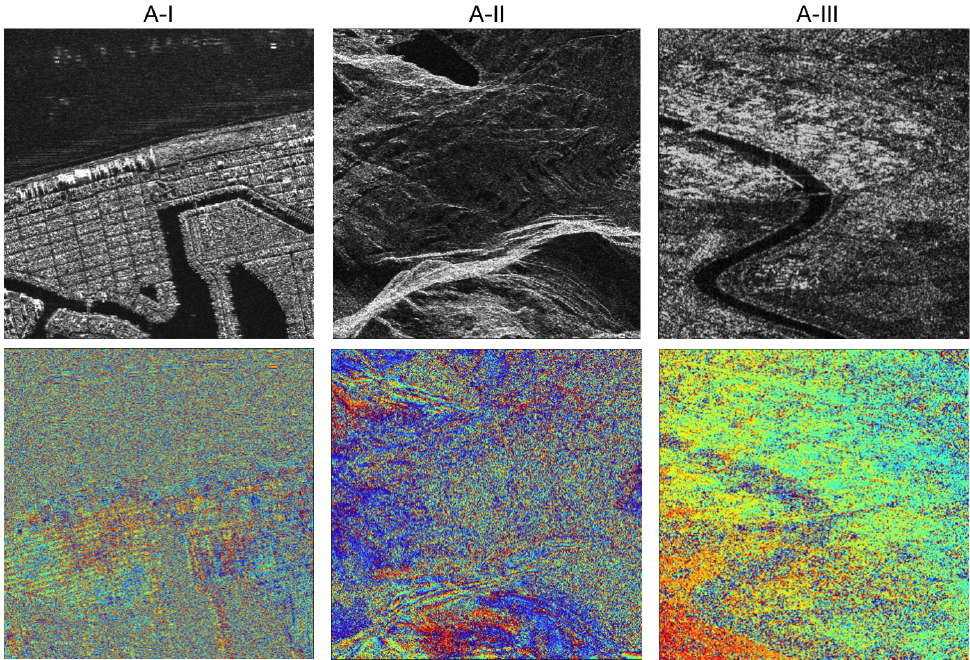
Figure 17. Amplitude ( top ) and corresponding noisy interferometric phase ( bottom ) of the three case study examples on real Interferometric Synthetic Aperture Radar (InSAR) data.